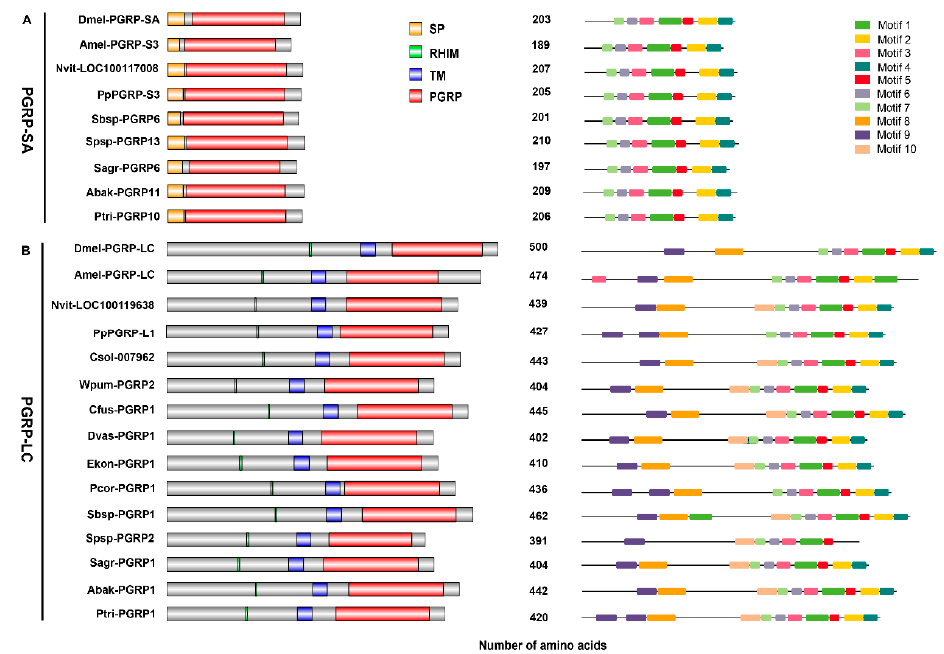
Figure 4. Domain and motif structure diagrams of PGRP-SAs ( A ) and PGRP-LCs ( B ). The domains were shown on the left (SP: signal peptide, RHIM: RIP homotypic interaction motif, TM: transmembrane domain, PGRP: peptidoglycan recognition protein), the motifs were marked with different colors on the right, and the number in the middle represented the length of amino acid of each PGRP. All of the PGRPs were from D. melanogaster (Dmel-), A. mellifera (Amel-), N. vitripennis (Nvit-), P. puparum (Pp) and the 12 fig wasp species.